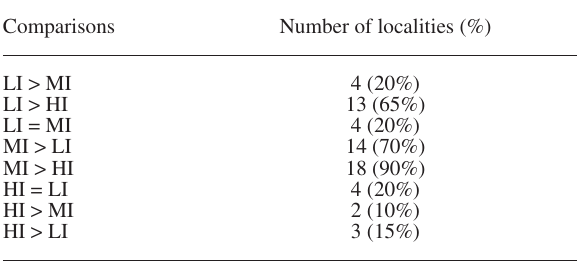
Table 2. − Summary of results of pair-wise comparisons of the abundance of Stramonita haemastoma between the three intertidal zones at the 24 localities. The numbers and percentages indicate the number of localities with a significant result (P<0.05). comparisons number of localities (%)